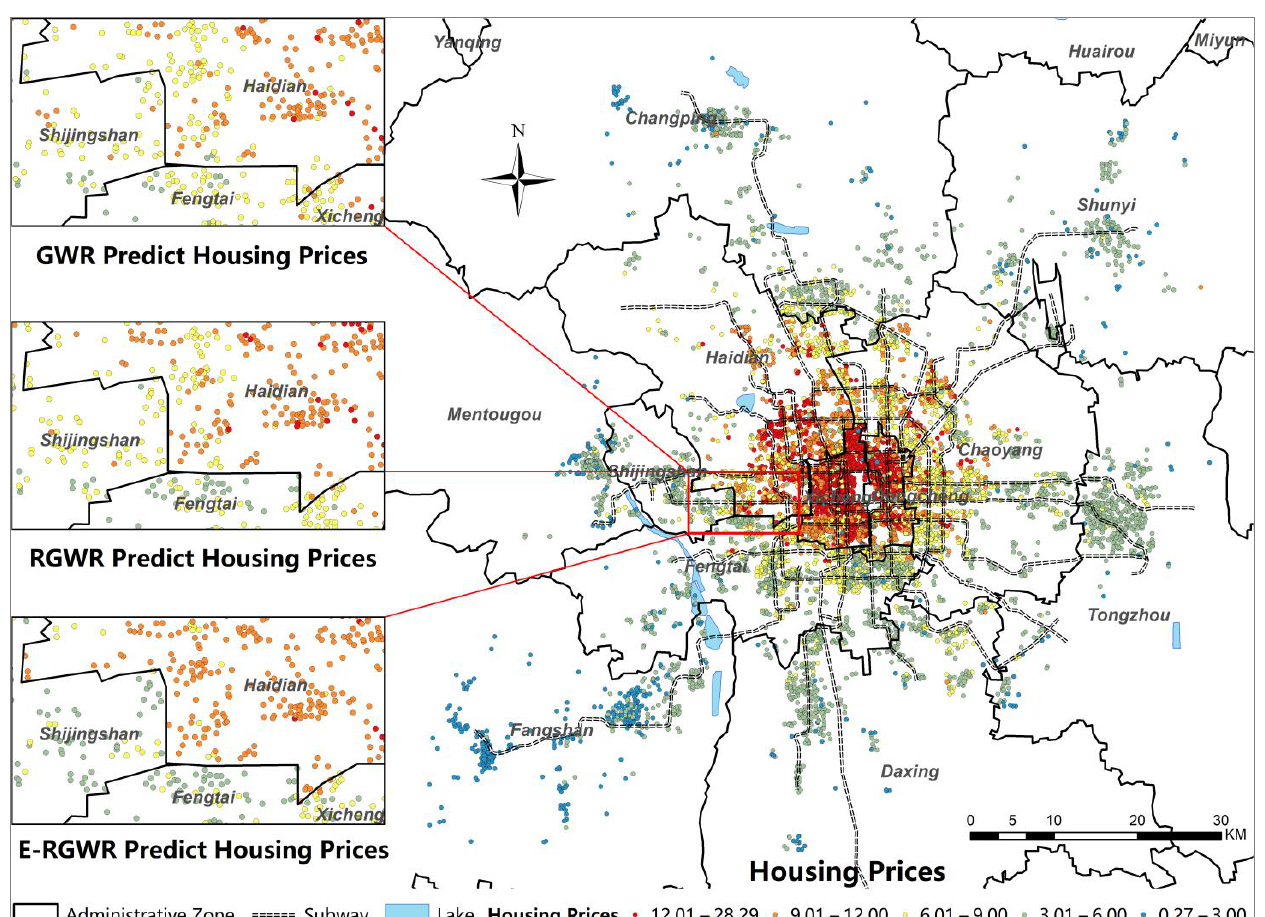
Figure 8. Local comparison chart of predicted values.